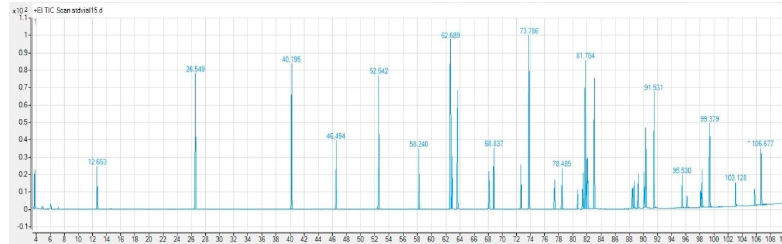
Figure 1. Chromatograms of a fatty acid methyl esters standard mix.